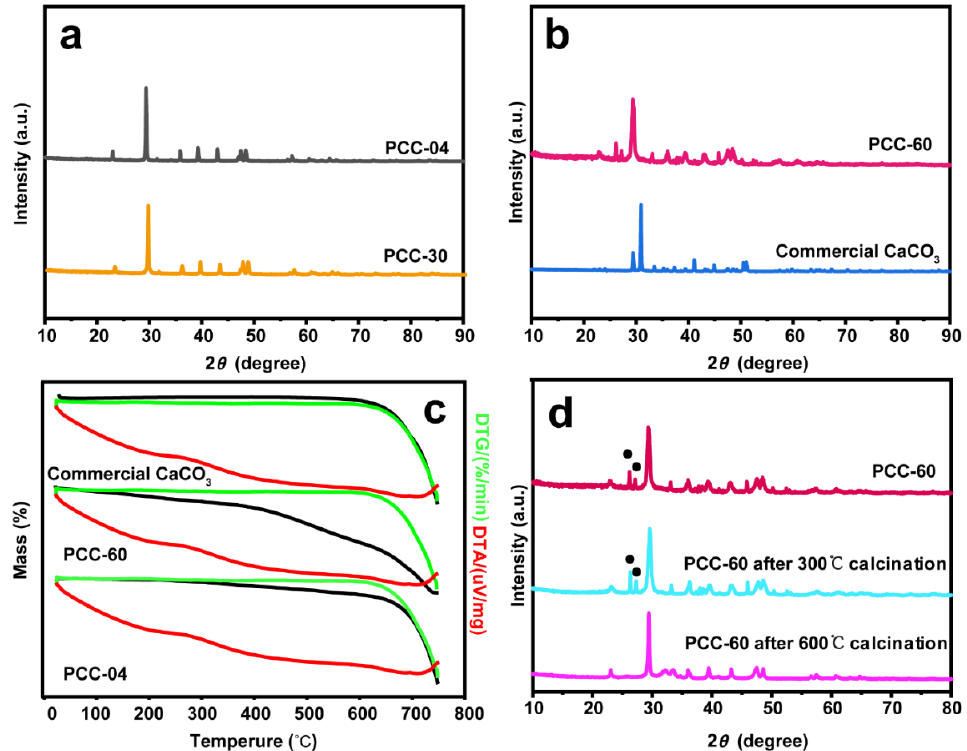
Figure 2. X-ray powder diffraction (XRD) patterns of standalone ( a ) PCC-04 and PCC-30, as well as ( b ) PCC-60 and commercial CaCO 3, indicate the existence of mixed phases (aragonite and calcite) in PCC-60. sample. ( c ) Thermogravimetric analysis (TGA) and differential thermal analysis (DTA) of standalone PCC-04, PCC-60, and commercial CaCO 3 supports, demonstrating higher mass loss in the PCC-60 sample only. ( d ) XRD pattern of standalone PCC-60 support after the calcination